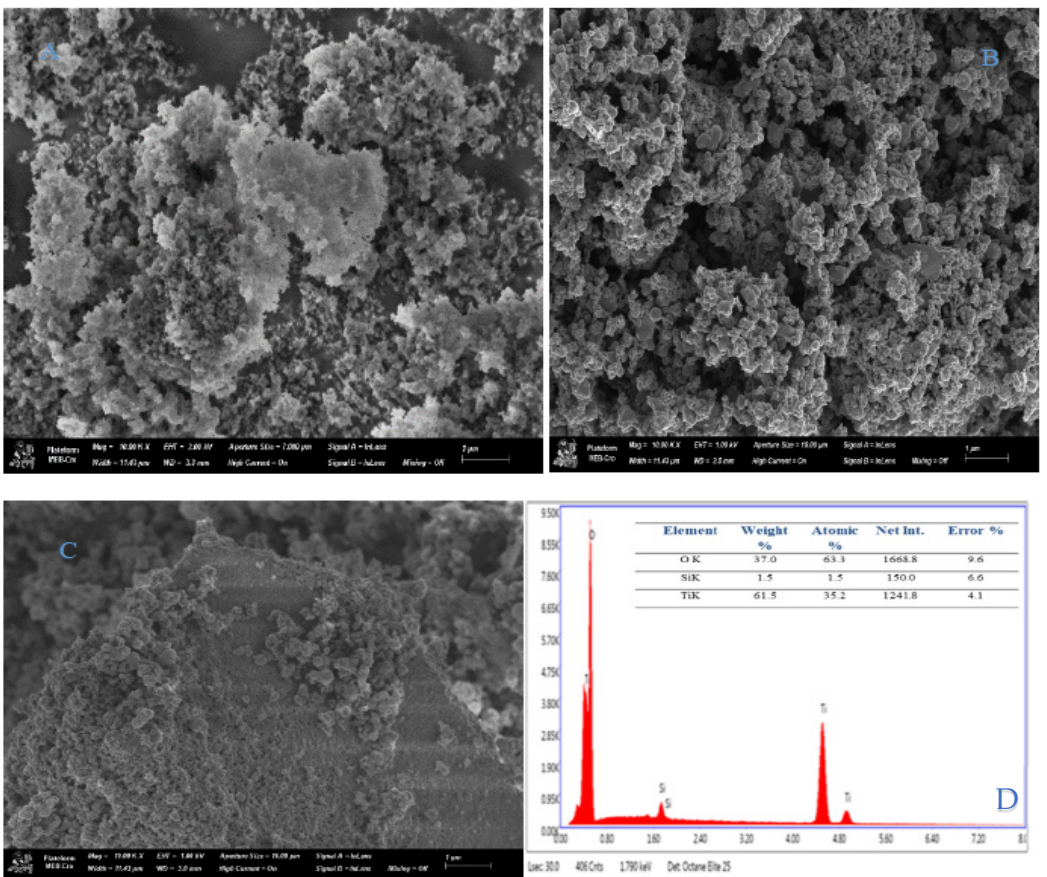
Figure 5. Scanning electron microscopy (SEM) of ( A ) SiO 2 , ( B ) TiO 2 , ( C ) T/S 20%, and ( D ) EDX-T/S 20%.